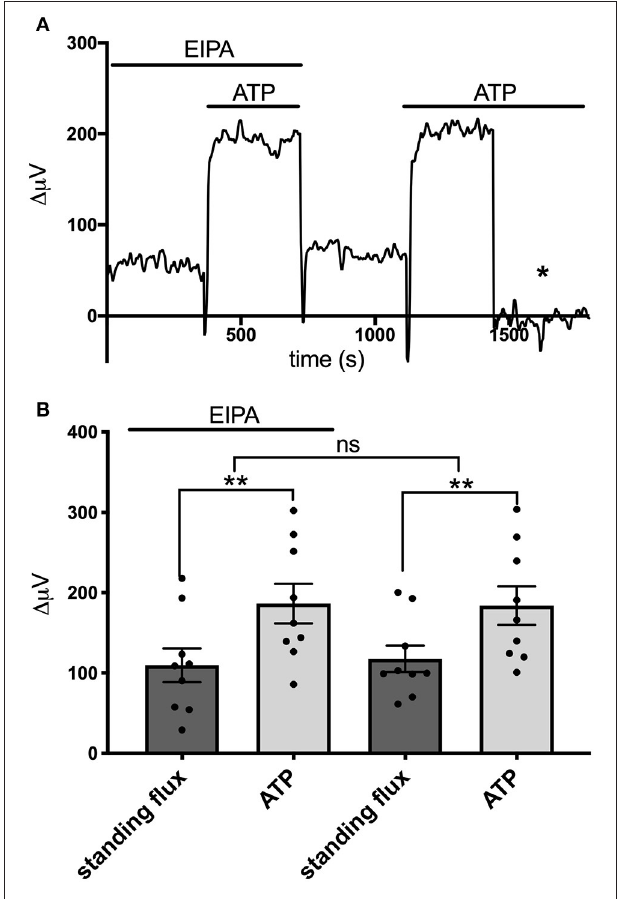
FIGURE 8 | Lack of effect of the Na + /H + inhibitor EIPA on H + flux. (A) Trace showing H + flux signal from a single astrocyte cultured from mouse hippocampus upon application of 100 µ M ATP first in the presence of 200 µ M EIPA and then again after the EIPA had been removed from the bath. (B) H + flux signals averaged from cells cultured from mouse hippocampus in the presence of EIPA and following washout of the drug; N = 9. **indicates P < 0.01; ns indicates not significantly different ( P >